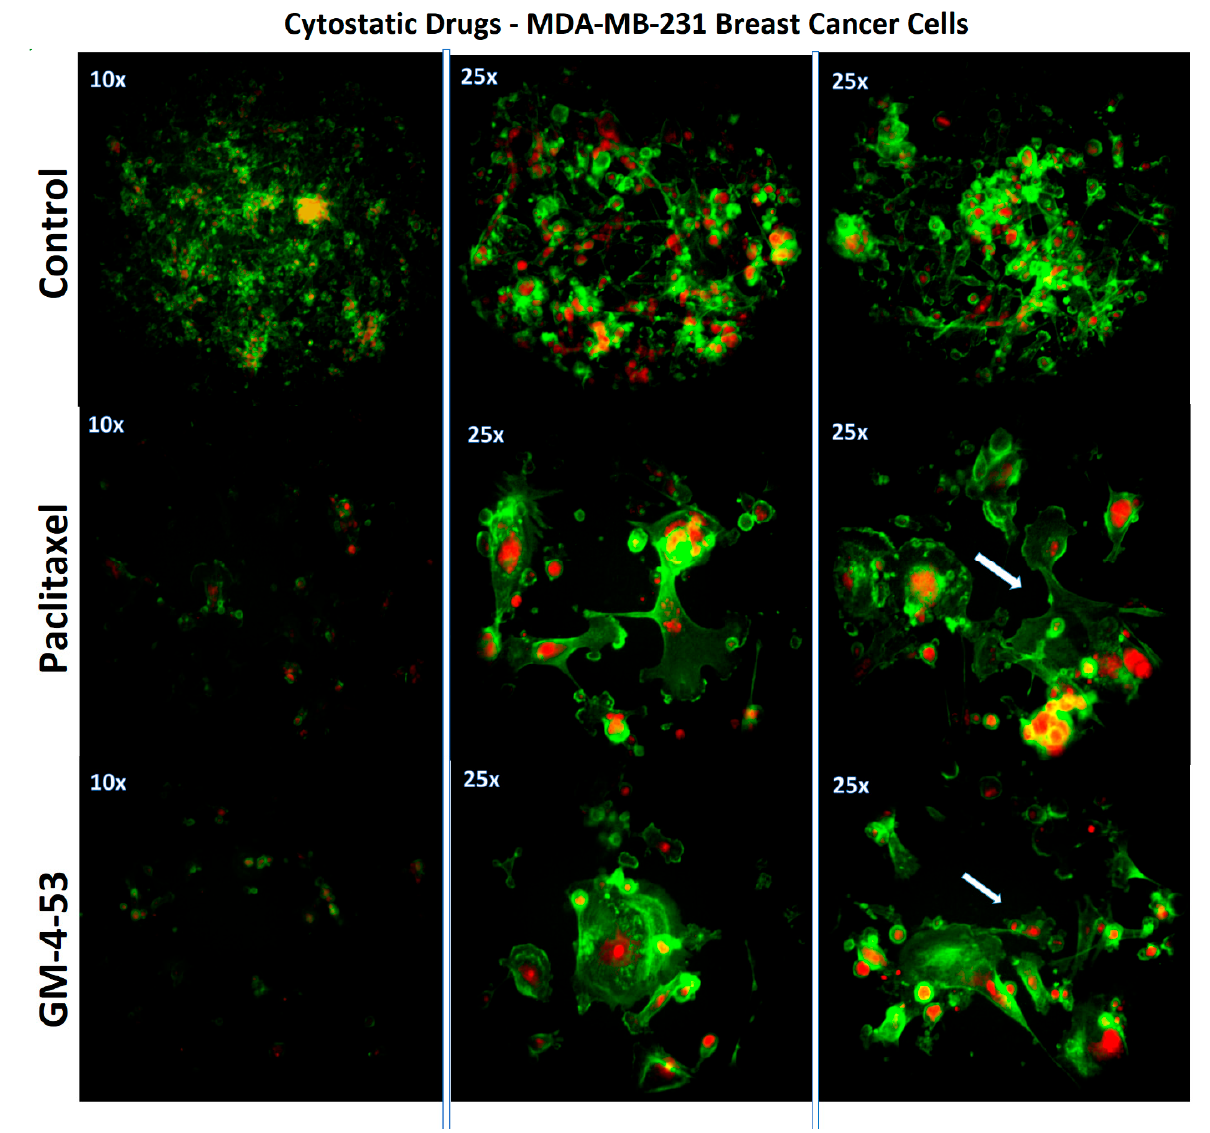
Figure 3. Morphological Changes associated with cytostatic growth-inhibitory effects by GM-4-53 5 µg/mL and paclitaxel 1 µg/mL in MDA-MB-231 cells evaluated at day 6. The images demonstrate cytostatic changes to the actin cytoskeletal architecture (green) with a propidium iodide nuclear counterstain (red) in the presence of either drug vs. untreated controls. [10×] shows the basic overview of accumulated cell number (cell proliferation), where [25×] shows higher magnification to enable visualization of deformed cell morphology n = 2. The images show abnormally large-shaped extended actin networks in cells that are unable to divide. Table 1. Variable cell line: cytostatic growth-inhibitory effects of GM-4-53 in Ishikawa, MCF-7 vs. MDA-MB-231 cells were determined by regression analysis. The data show a consistent cytostatic effect in diverse female cancers in the mid-to-high nM